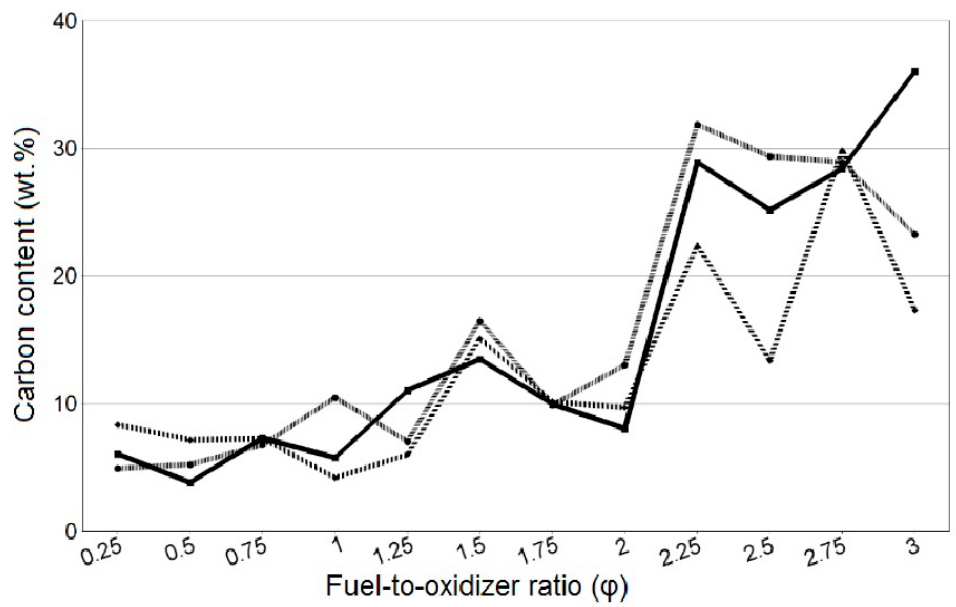
Figure 5. Local carbon content (wt.%) at three spots of the SCS product at different ϕ .